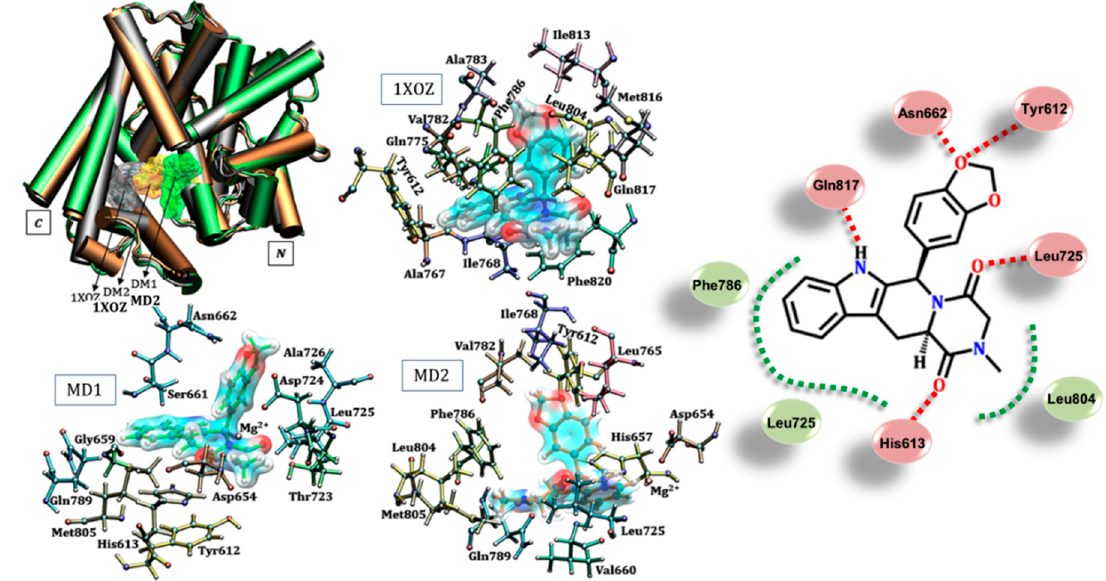
Figure 2. Interactions identified between the tadalafil and specific amino acids in the catalytic domain of PDE5 considering three di ff erent protein structures: crystallographic and two from 80 ns molecular dynamics (MD) simulations (MD1 and MD2). Residues considered only at distance equal to or less than 3.0 Å from the ligand (r ≤ 3.0 Å). Legend of interactions, red: hydrogen bond (and dipole–dipole); green: